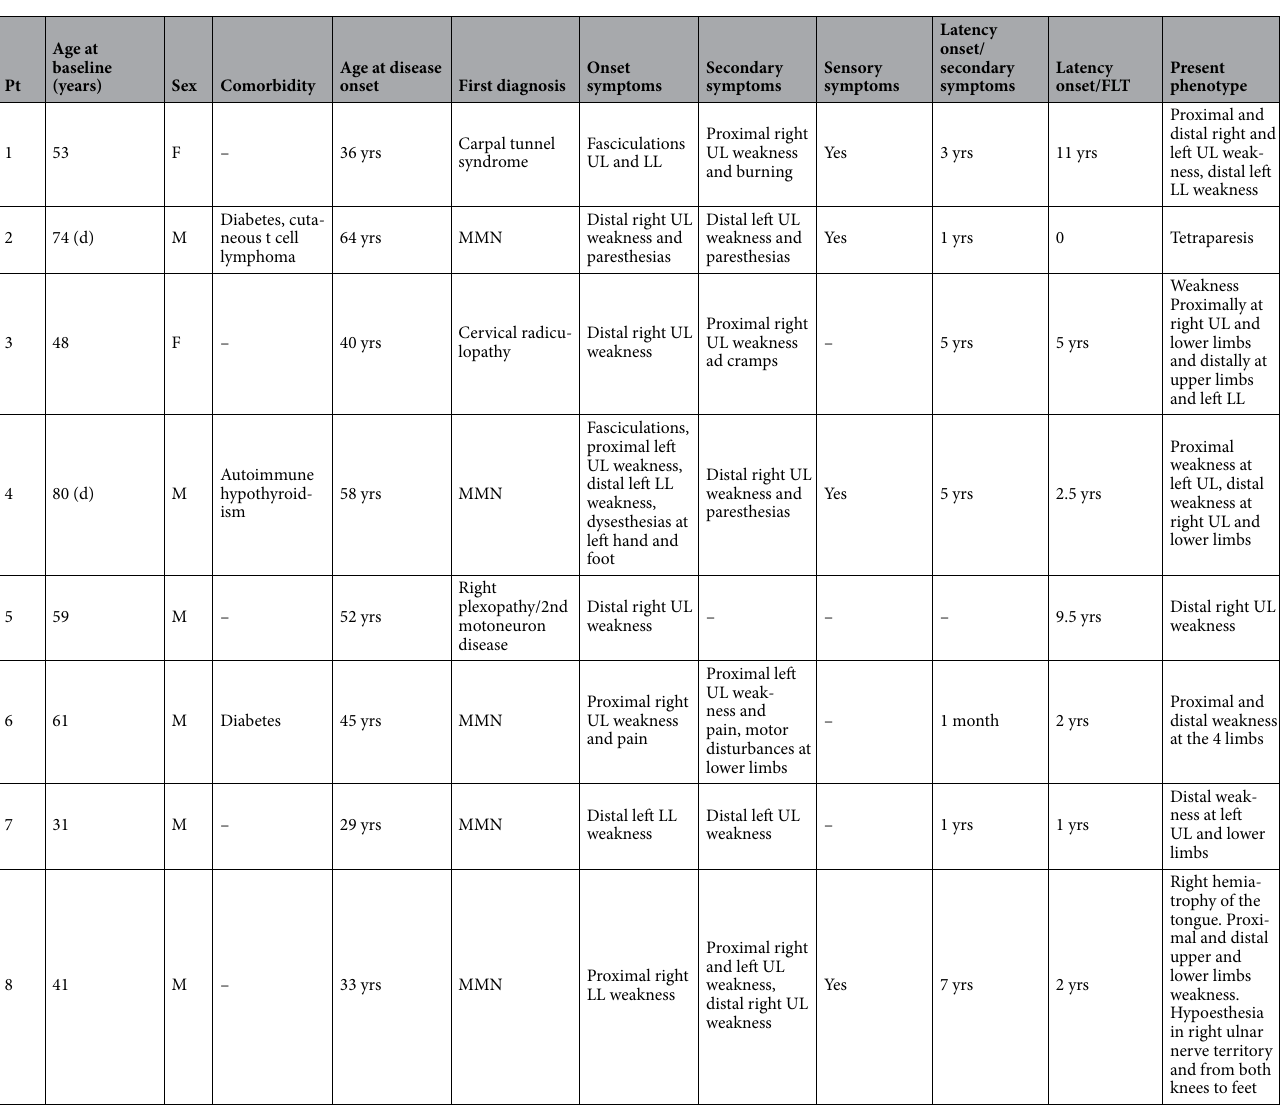
not to be intended as consecutive: once disease regression was reached, cyclophosphamide was stopped and restarted only in case of relapses. This treatment was then definitely interrupted because of side effects (hemor- rhagic cystitis in two cases, leukopenia and thrombocytopenia in the other). These three patients, after cyclo- phosphamide, underwent other immunomodulatory treatment (rituximab, azathioprine, interferon-beta) with